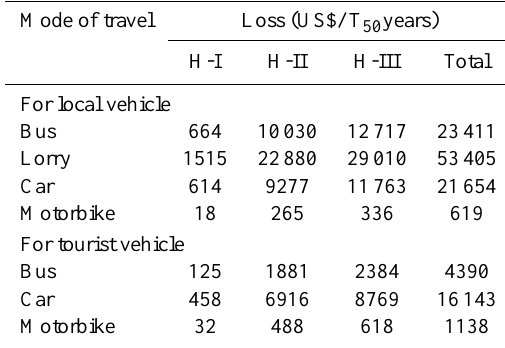
Table 9. Loss due to additional fuel consumption.